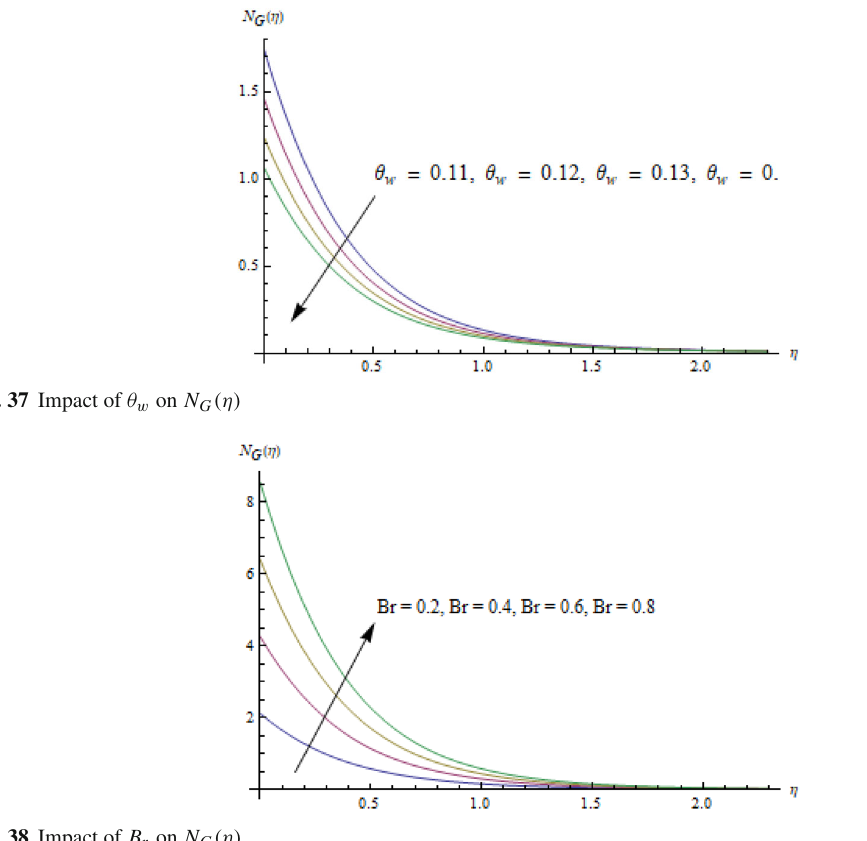
Fig. 38 Impact of B r on N G (η) Table 2 Values of skin-friction coefficient 1 λ α